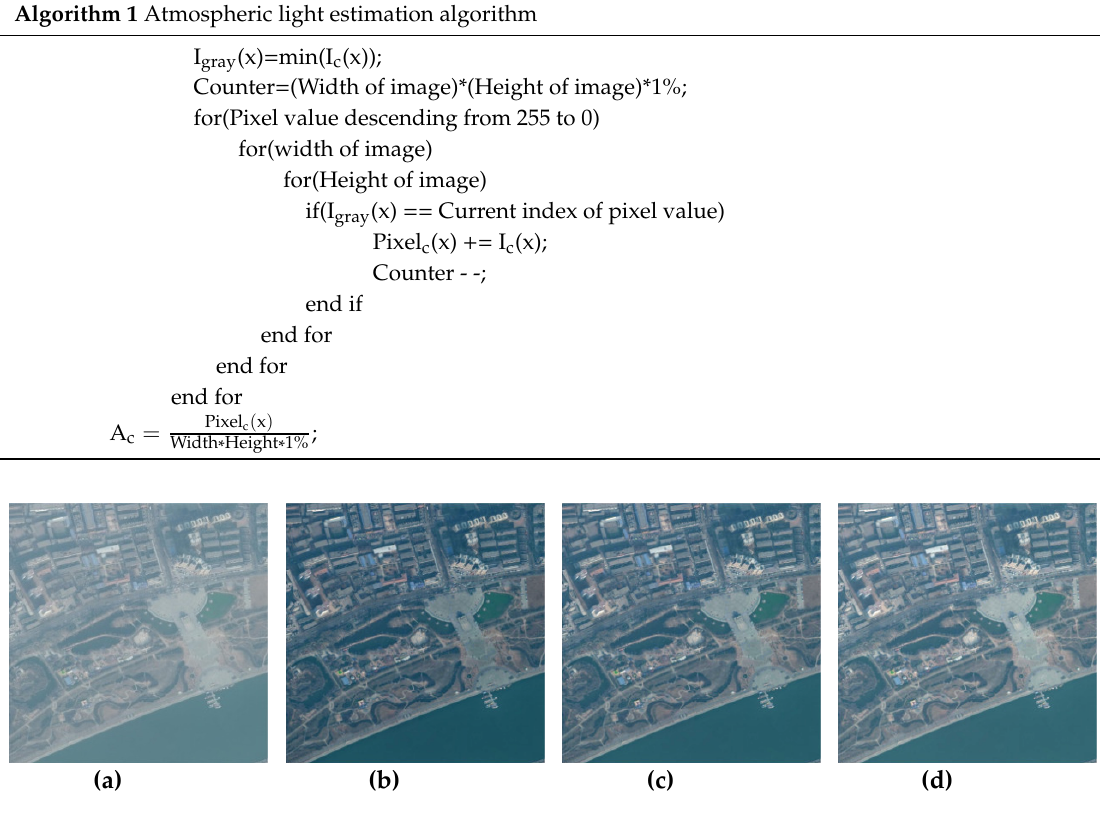
Algorithm 1 Atmospheric light estimation algorithm